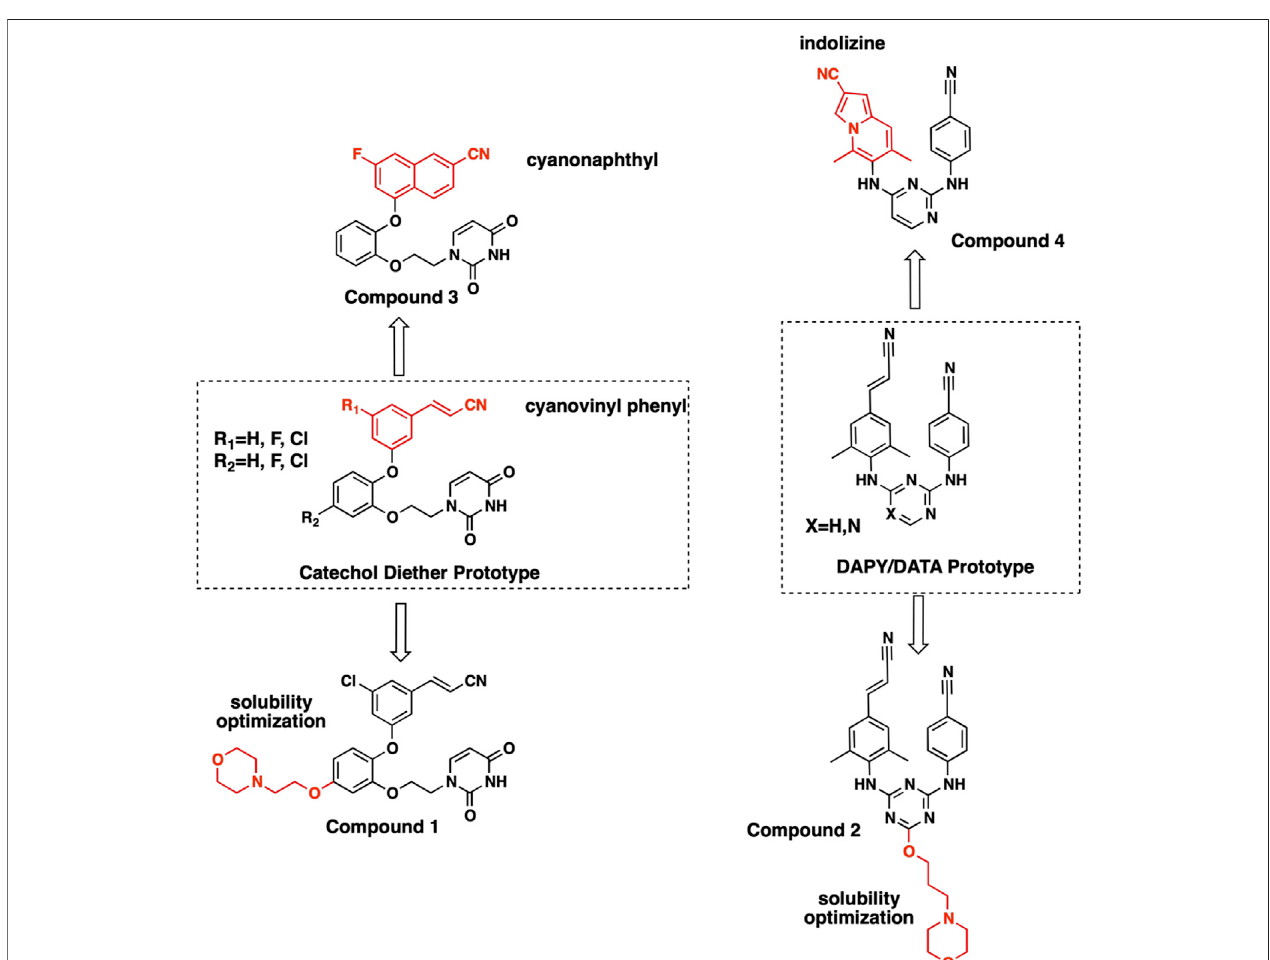
FIGURE 1 | Structures of NNRTI compounds co-crystallized with RT and evaluated for SAR. Synthesis and characterization for compound 1 is provided in Supplementary Material. Synthesis and characterization for compounds 2-4 have been reported previously (Lee et al., 2014; Lee et al., 2015).